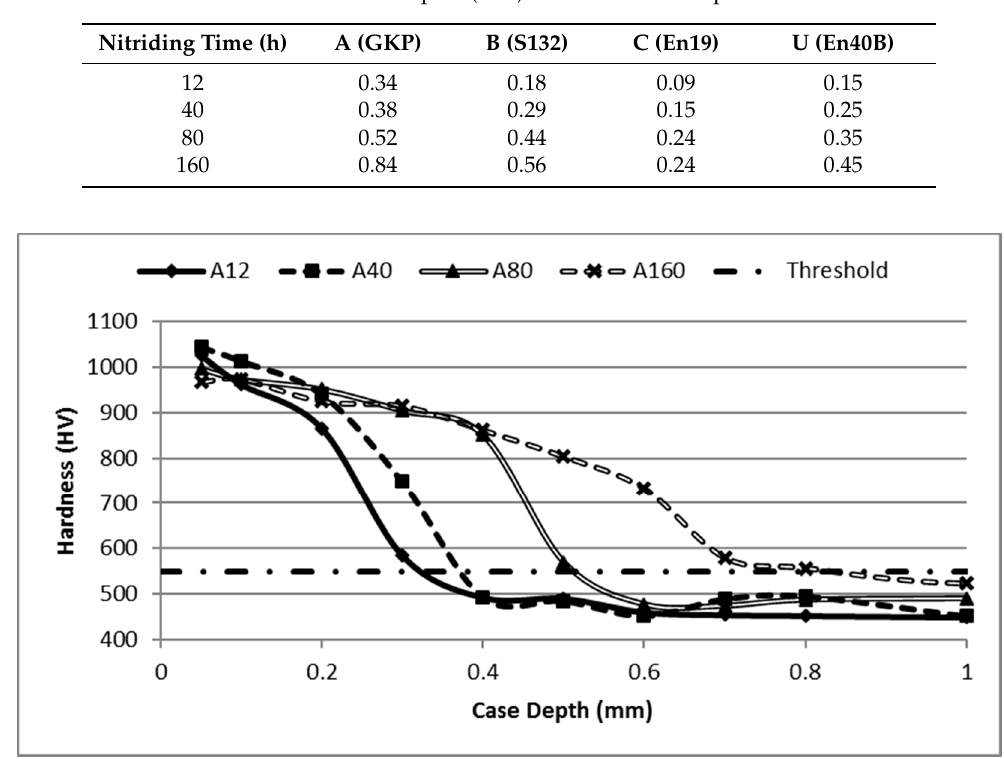
Figure 3. Determination of case depths for sample A (GKP) with the threshold value of 550 HV.